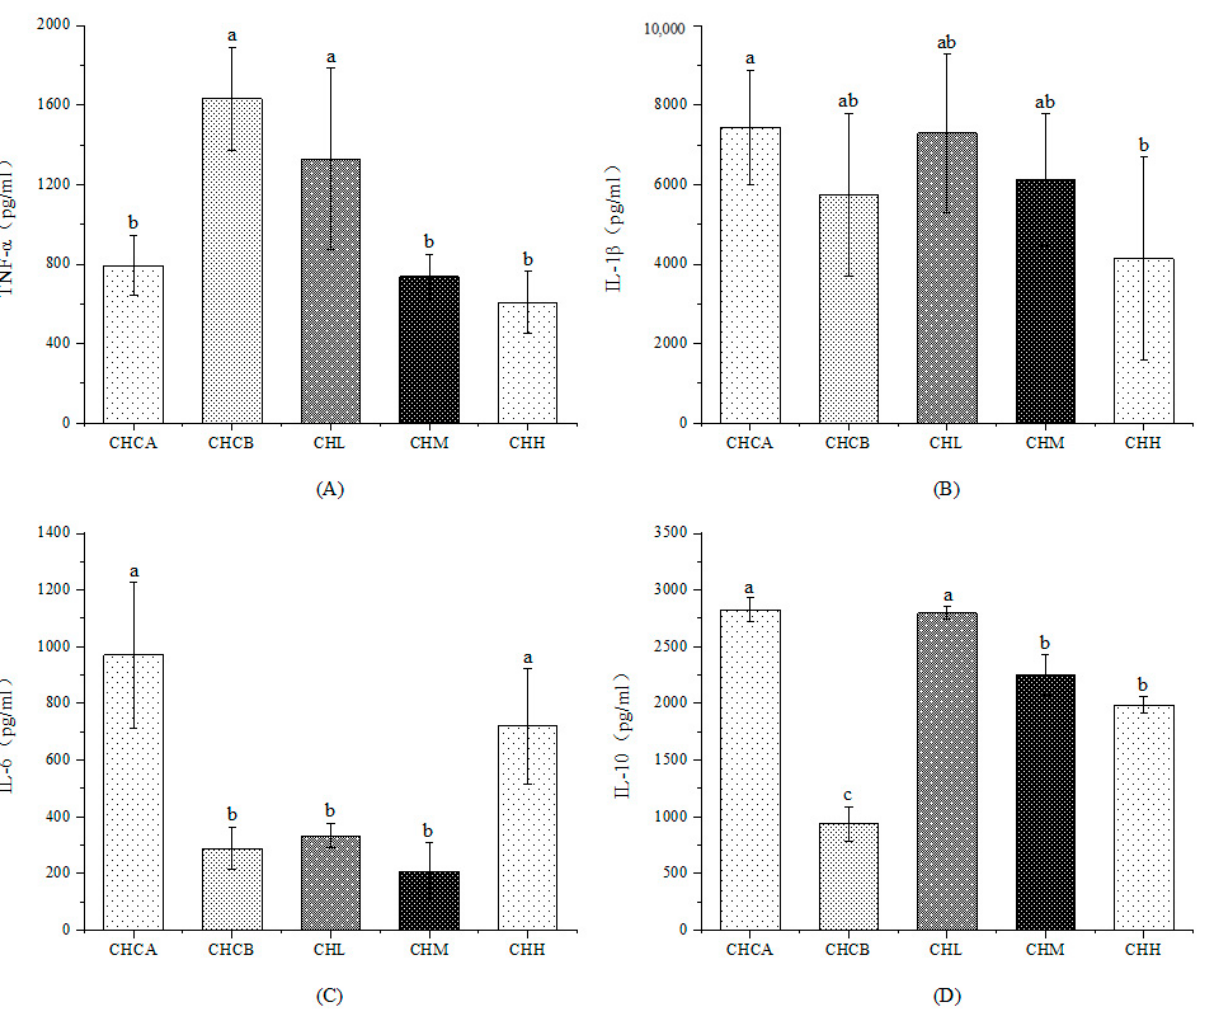
Figure 1. Effects of CIF on serum inflammatory factors level. ( A ): TNF- α , ( B ): IL-1 β , ( C ): IL-6, ( D ): IL-10. Values indicate mean ± SEM (n = 5). a, b, c Values not sharing a common letter are significantly different among the groups ( p ≤ 0.05).